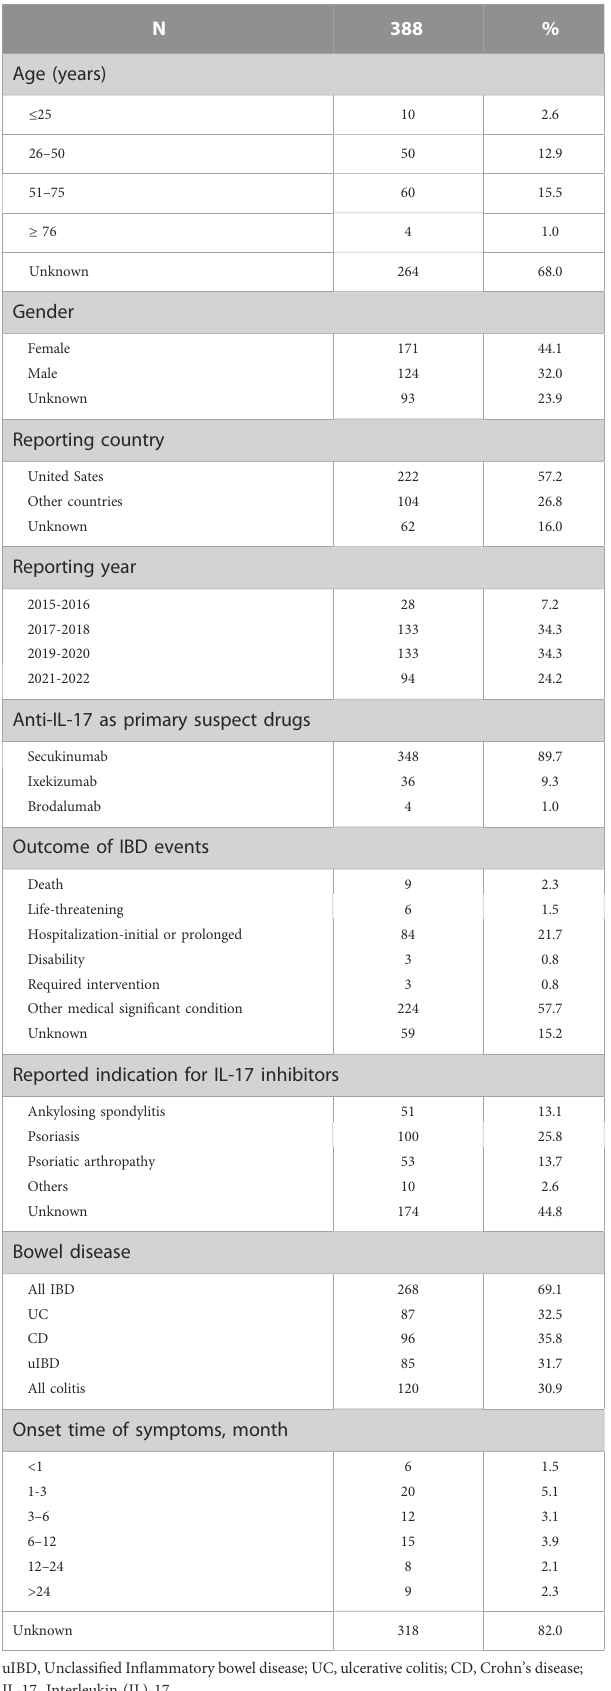
TABLE 1 Main characteristics of primary suspect cases in FAERS